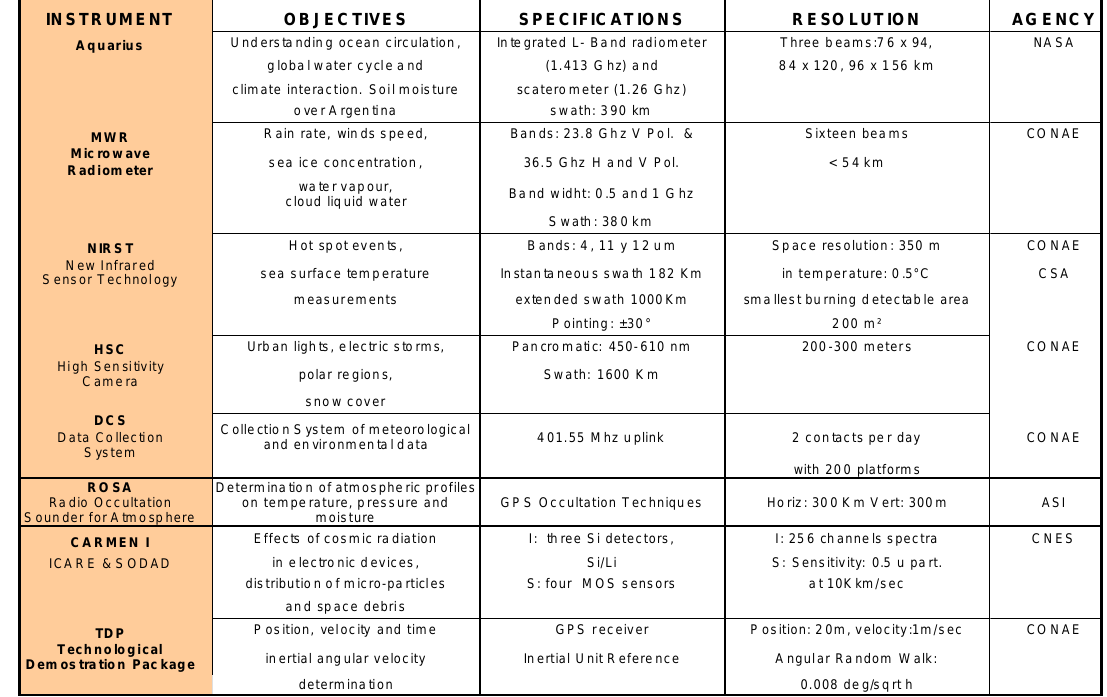
Table 1: Main characteristics and applications of each instrument on board SAC-D/